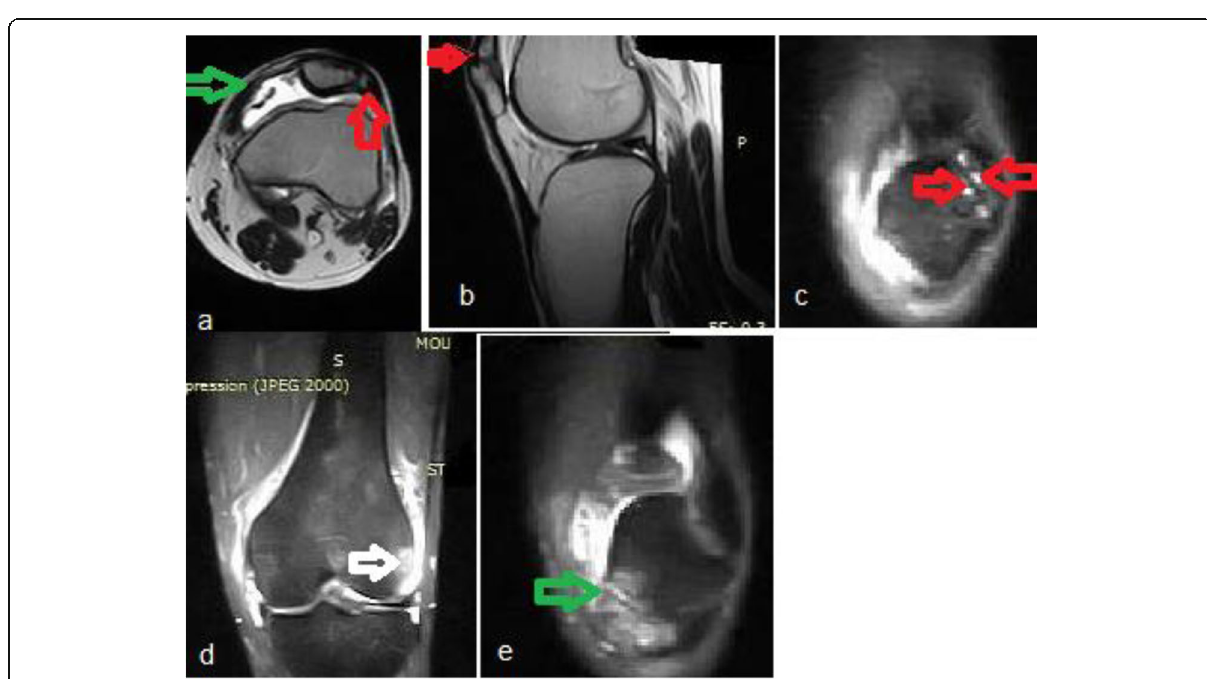
Fig. 6 a – e MRI images for the third type bipartite patella with degenerative changes at the synchondrosis and transient patellar dislocation. a Axial, b sagittal. and c coronal STIR images demonstrated a well-corticated non united fragment along the superolateral part of the patella (red arrows in a and b ); also note the pseudocysts at the opposing surfaces of the synchondrosis (open red arrows in c ) and the medial patellar retinaculum with an intra-substance bright signal (green arrow in a ). d , e Coronal STIR WIs demonstrated kissing bone contusions at the lateral